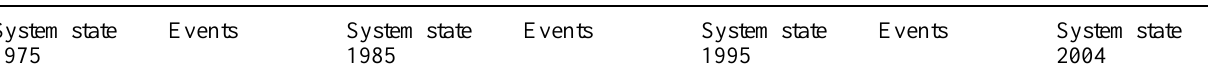
Table 1. Scheme of developments at three levels of scale (macro, meso, micro) that have influenced the system state of water management in The Netherlands over a time period (1975–2004). System states are described in terms of management concept, approach, and priorities (1975, 1985, 1995, 2004). Taken from (van der Brugge et al.